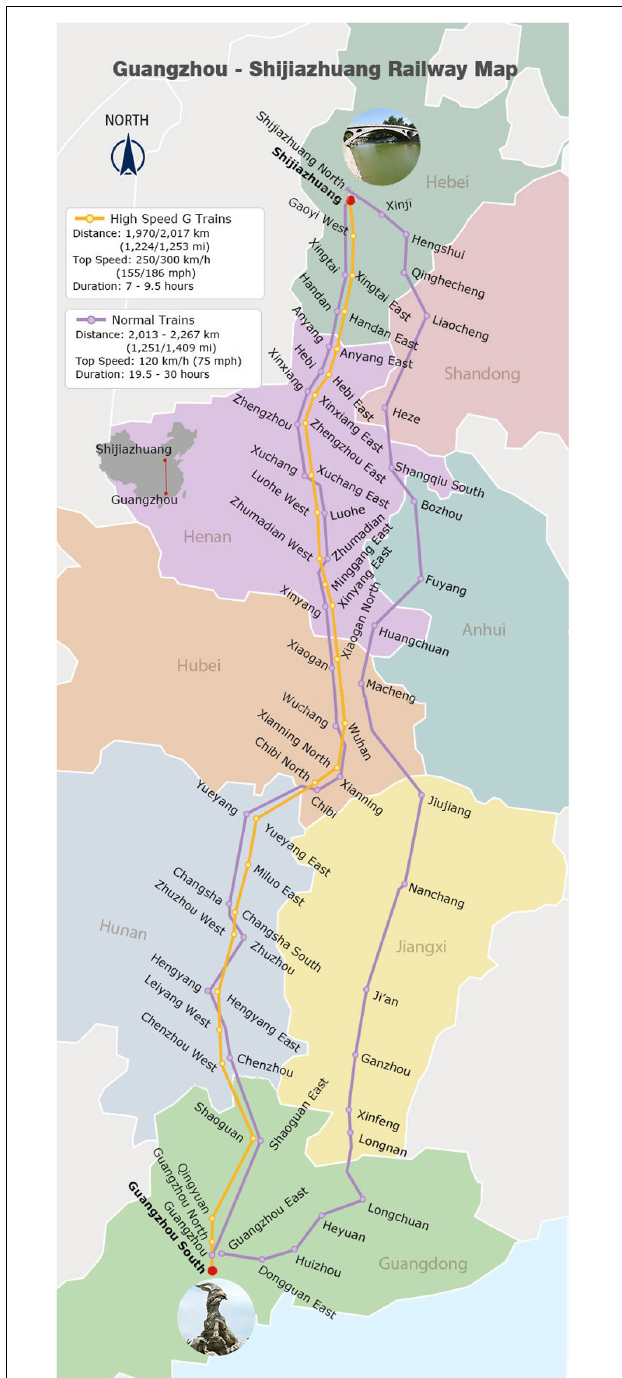
FIGURE 7 | Demonstration of areas with high prevalence of the coronavirus (Travel China Guide, 2020).